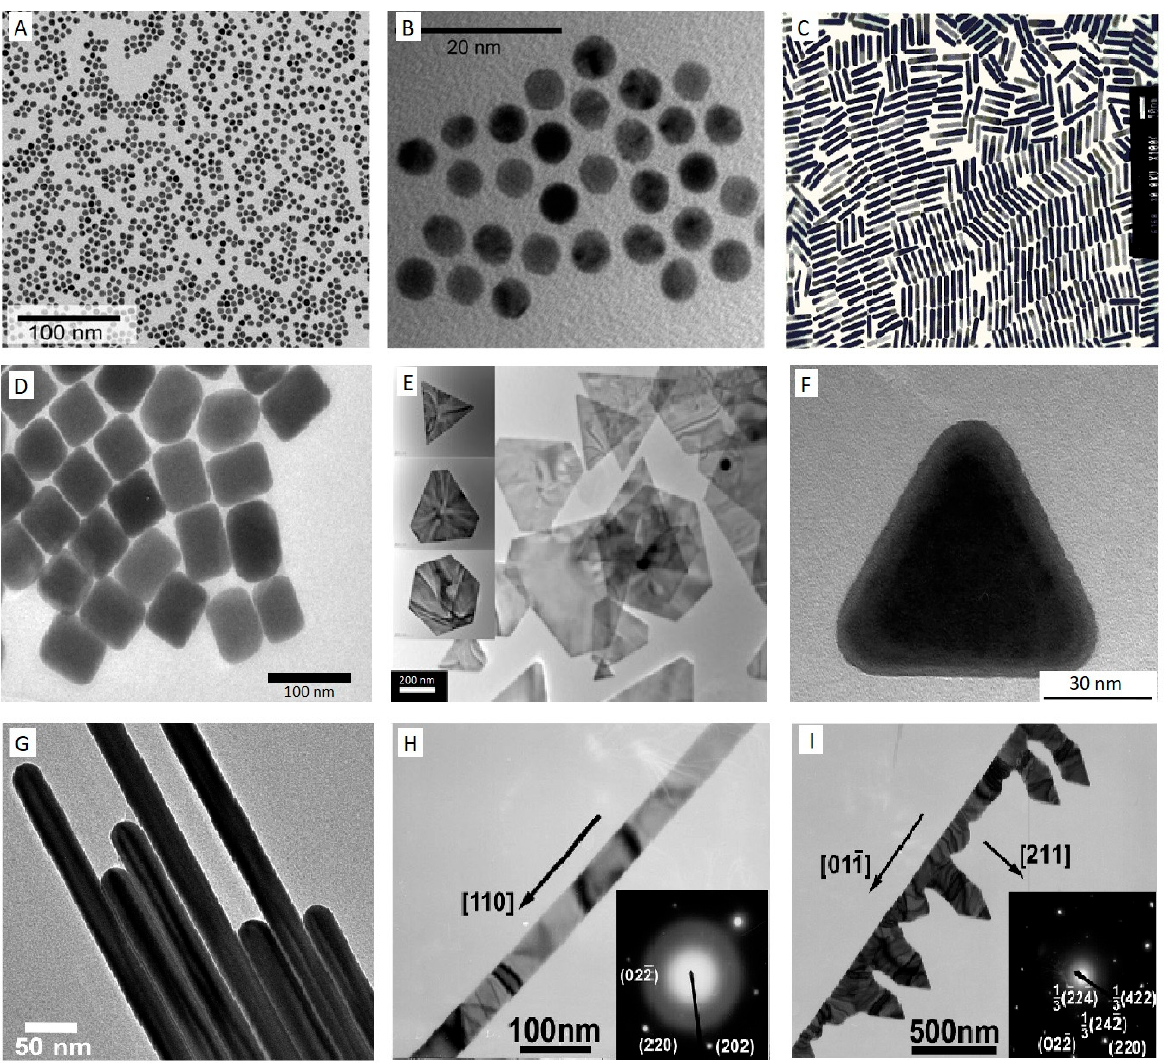
Figure 1. TEM images of Au nanostructures ( A – I ), Au nanospheres ( A , B ) [111], AuNRs ( C ) [100], Au nanocubes ( D ) [101], Au nanoplates ( E ) [104], Au nanoprism ( F ) [103], Au nanowire ( G ) [106], Au nanobelt ( H ), and Au nanocomb ( I ) [108]. Reprinted with permission from respective sources.